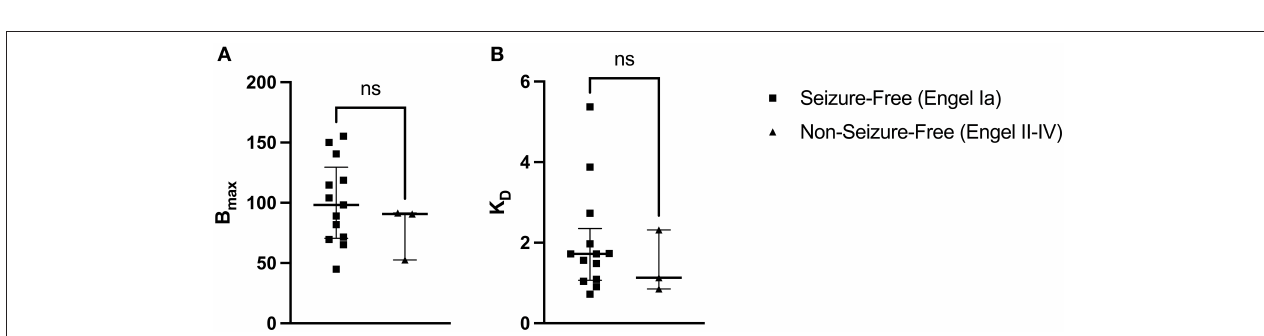
FIGURE 4 | [ 3 H]ABP688 B max and K D in seizure-free (Engel Ia) and non-seizure-free (Engel II–IV) patients. Receptor densities (B max ; in fmol/mg) and dissociation constants (K D ) in hippocampal specimens from mesial temporal lobe epilepsy (mTLE) patients who achieved seizure freedom following surgery and patients who did not achieve seizure freedom. (A) B max values were not significantly different between seizure-free and non-seizure-free groups. (B) K D values were not significantly different between seizure-free and non-seizure-free groups. Values are represented as median with interquartile range; ns, indicates a non-significant comparison.